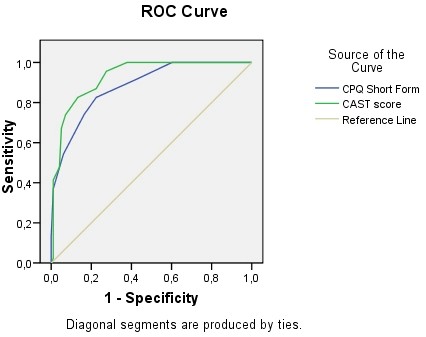
ROC curves for the CAST and CPQ-A-S instruments. The figure shows the ROC curve with Specificity and Sensitivity of the Cannabis Abuse Screening Test (CAST) and the Cannabis Problems Questionnaire for Adolescents - Short Form (CPQ-A-S) to detect Cannabis Dependence, as assessed by DSM-IV-TR.